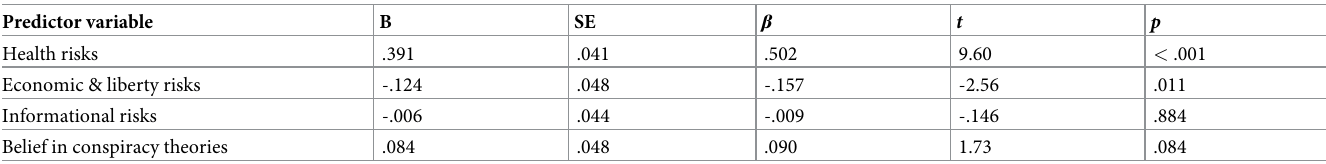
Table 3. Regression coefficients for compliant